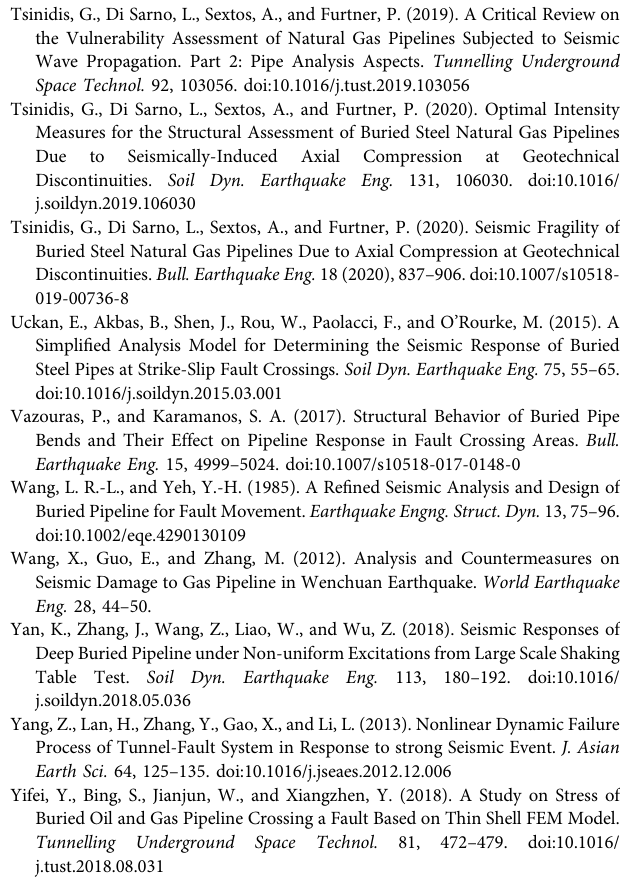
Table Test. Soil Dyn. Earthquake Eng. 113, 180 – 192. doi:10.1016/